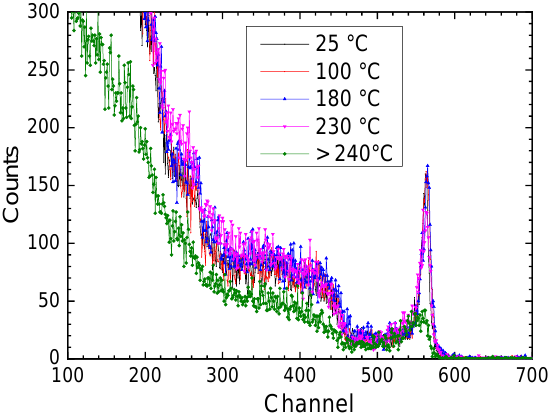
Figure 24. PHS measured at different temperatures for a 500 μ m thick diamond detectors with two Ag contacts post-deposition annealed to form ohmic Ag contacts post-deposition annealed to form ohmic contacts.